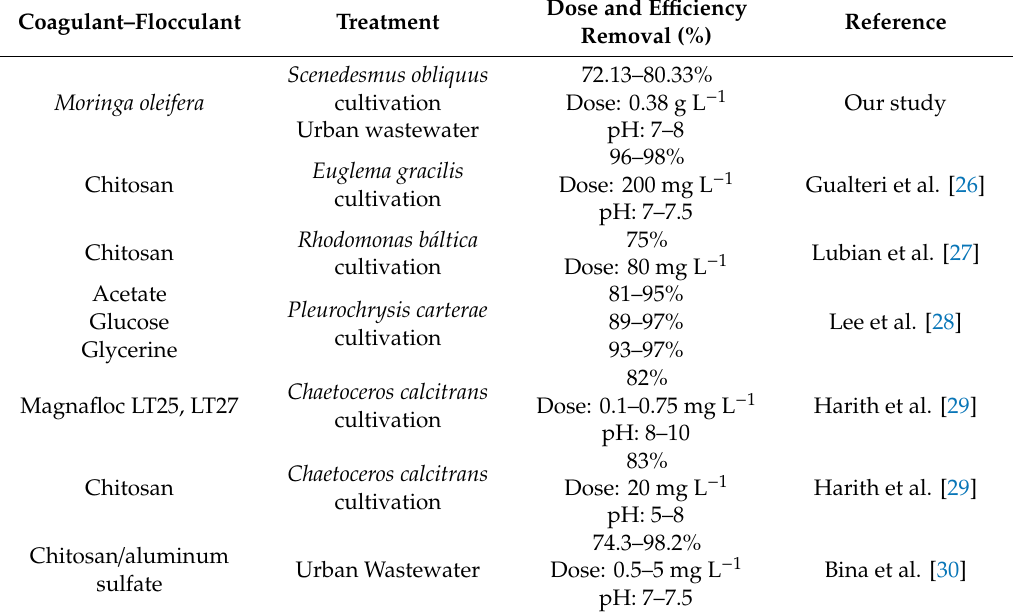
Table 5. Comparative e ffi ciency and dose of flocculants in algal culture media and wastewater.